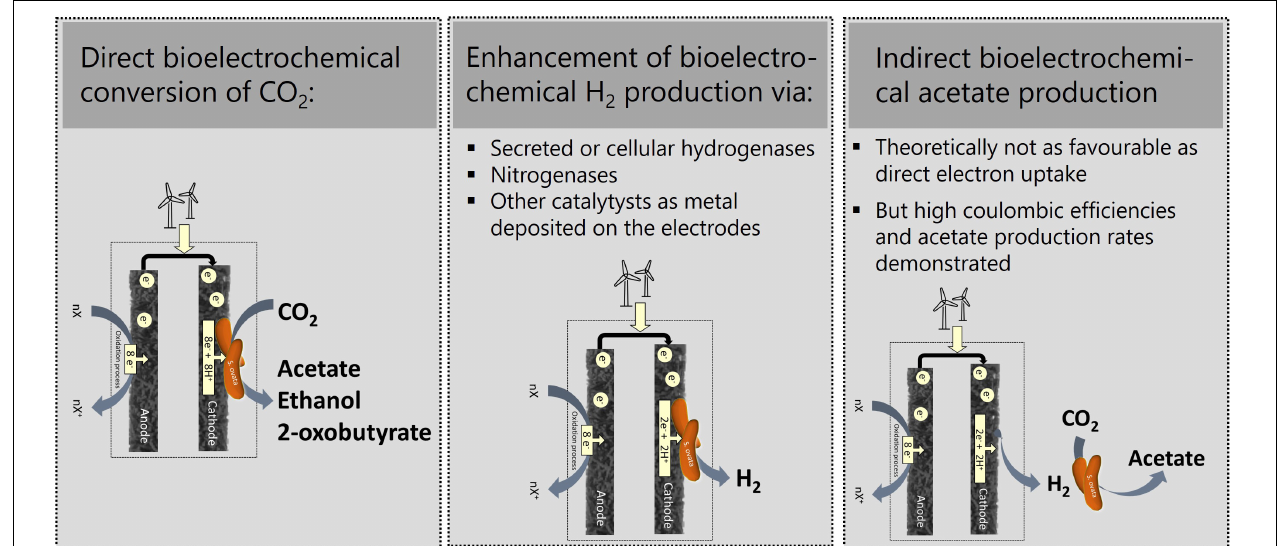
FIGURE 1 | Basic principles and versatility of microbial electrosynthesis with S.